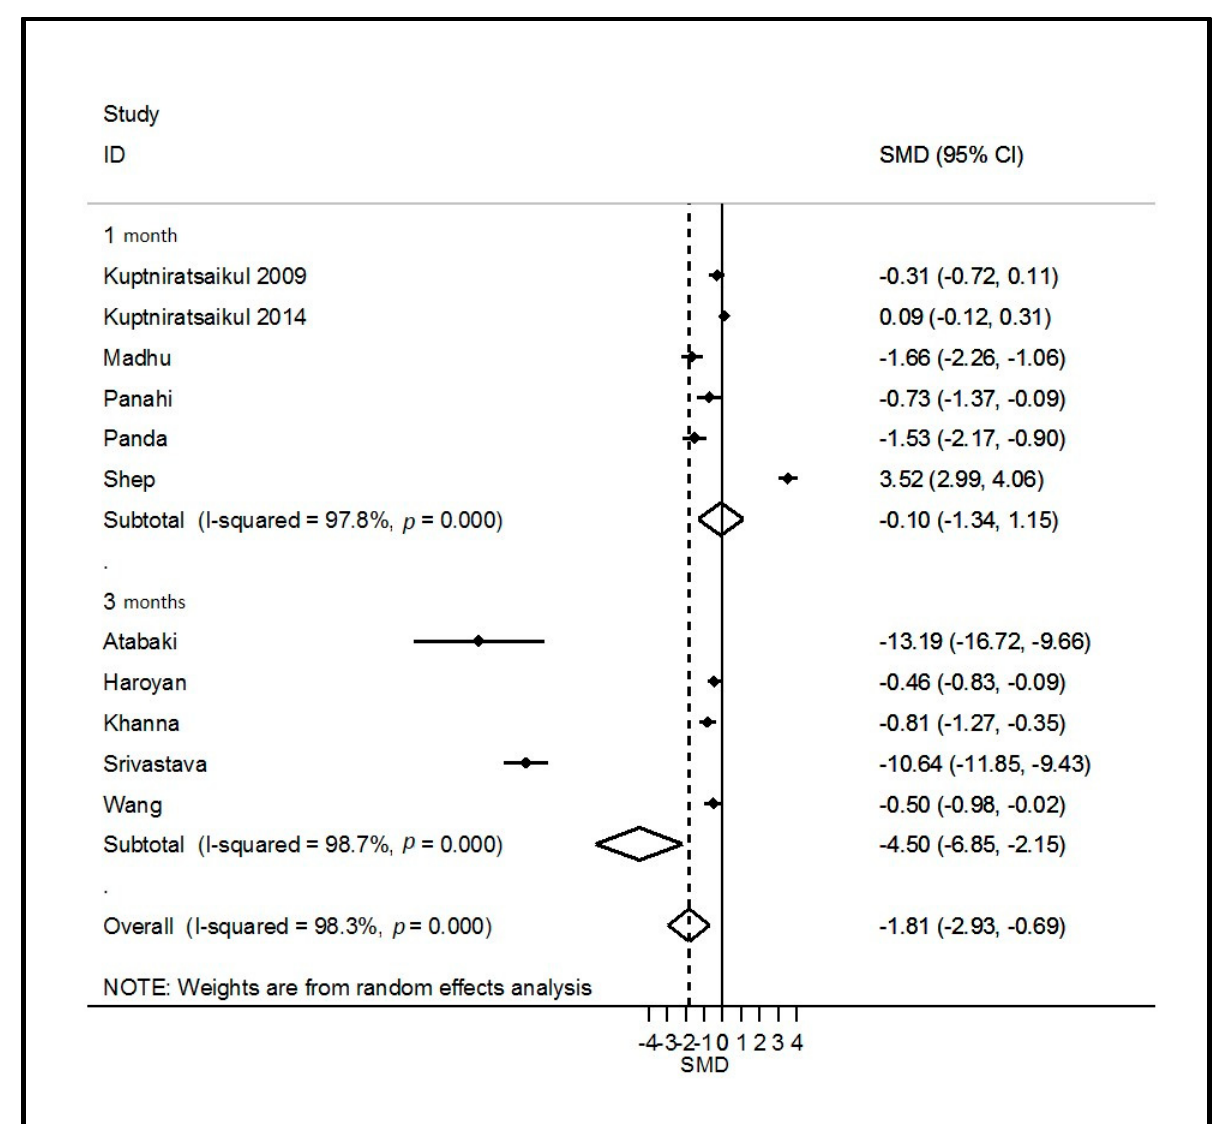
Figure 2. Forest plot of the effects of curcumin on pain . ID = study identity; SMD = standard mean difference; CI = confidence interval